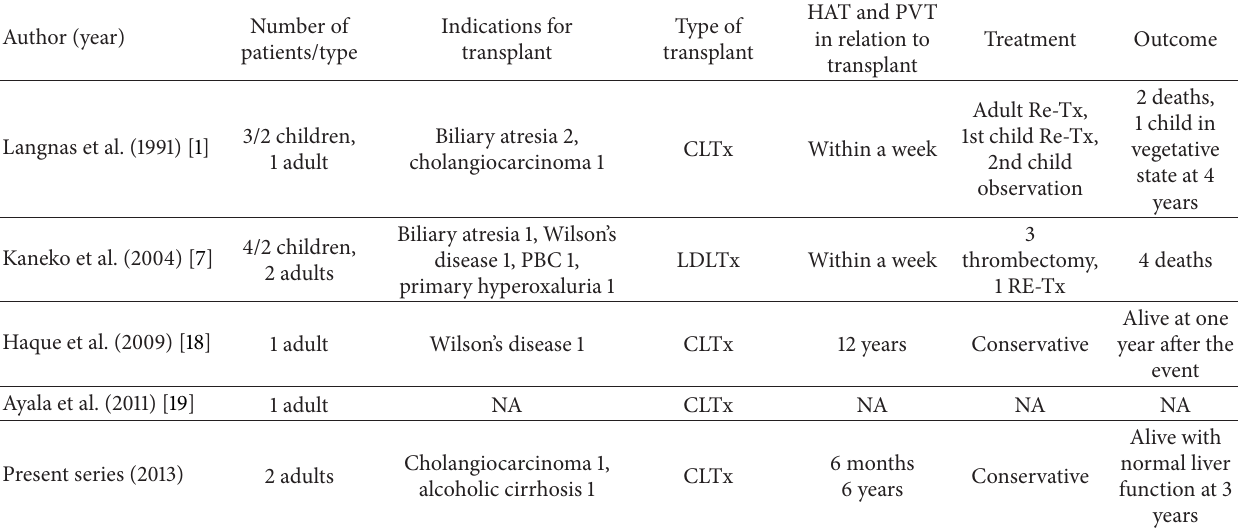
Table 1: Depiction of cases with concurrent HAT and PVT in the